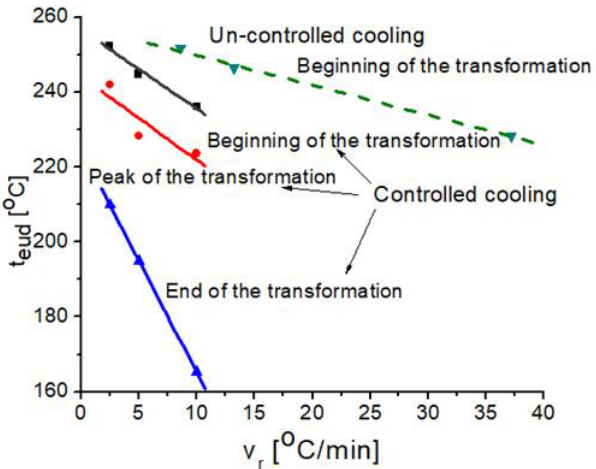
Figure 13. The registered overcooling in the eutectoid transformation via the controlled and un-controlled method during DIL analysis.